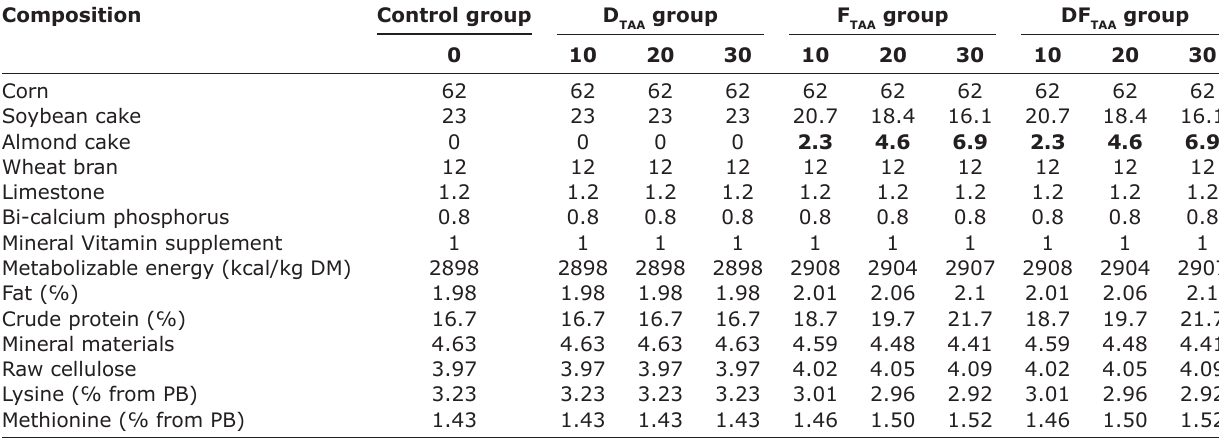
Table-3b: Formulas (kg/100 kg feed) of finishing (21-45 days) feeds to quail based on the rate of substitution of soybean meal by apricot kernel meal. Composition